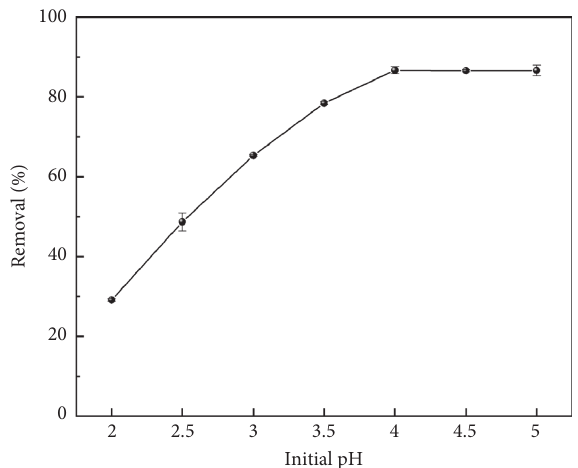
Figure 7: The effect of initial pH.